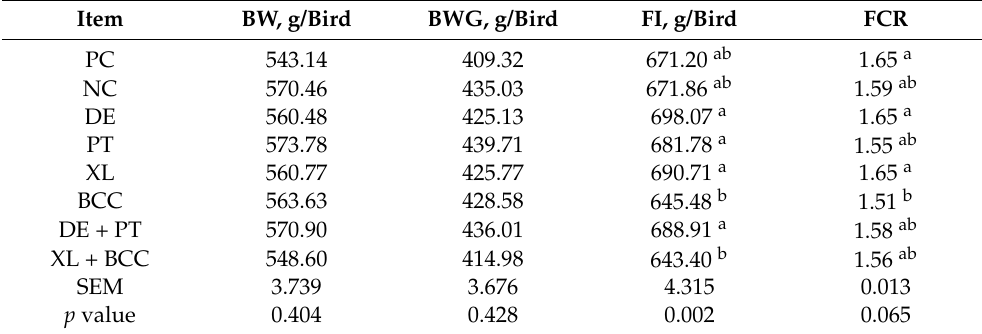
Table 4. Supplemental enzymes with probiotics on growth performance of broiler chickens from 1 to 21 days.